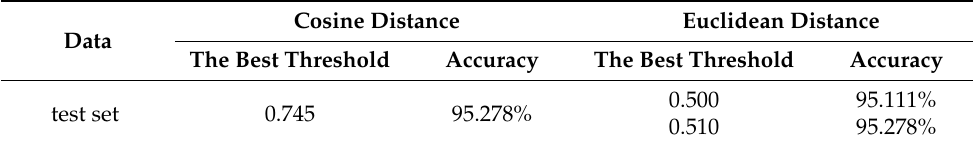
Table 7. Test results at different thresholds.